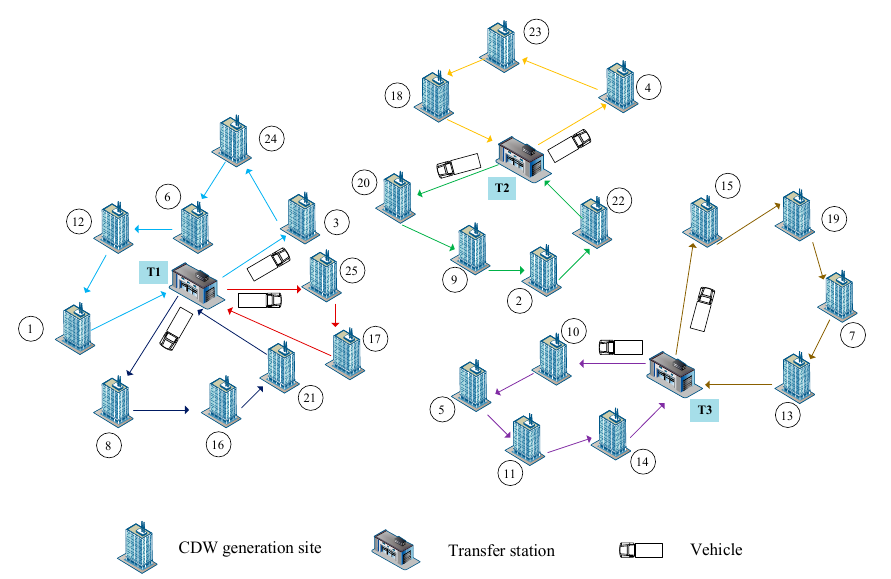
Figure 2. An example of MDVRPTW recycling